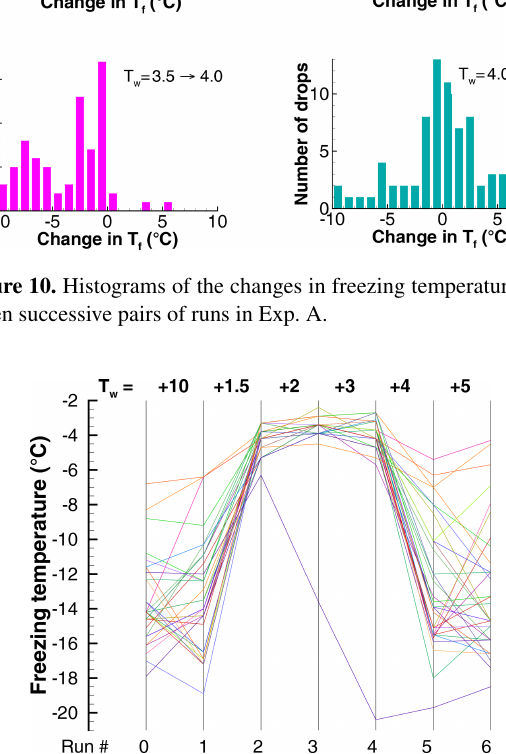
Figure 11. Spiderweb diagram of individual drop histories for the sequence of runs with increasing warm limits in Exp. B. A statistical representation of these observations is given in Fig.